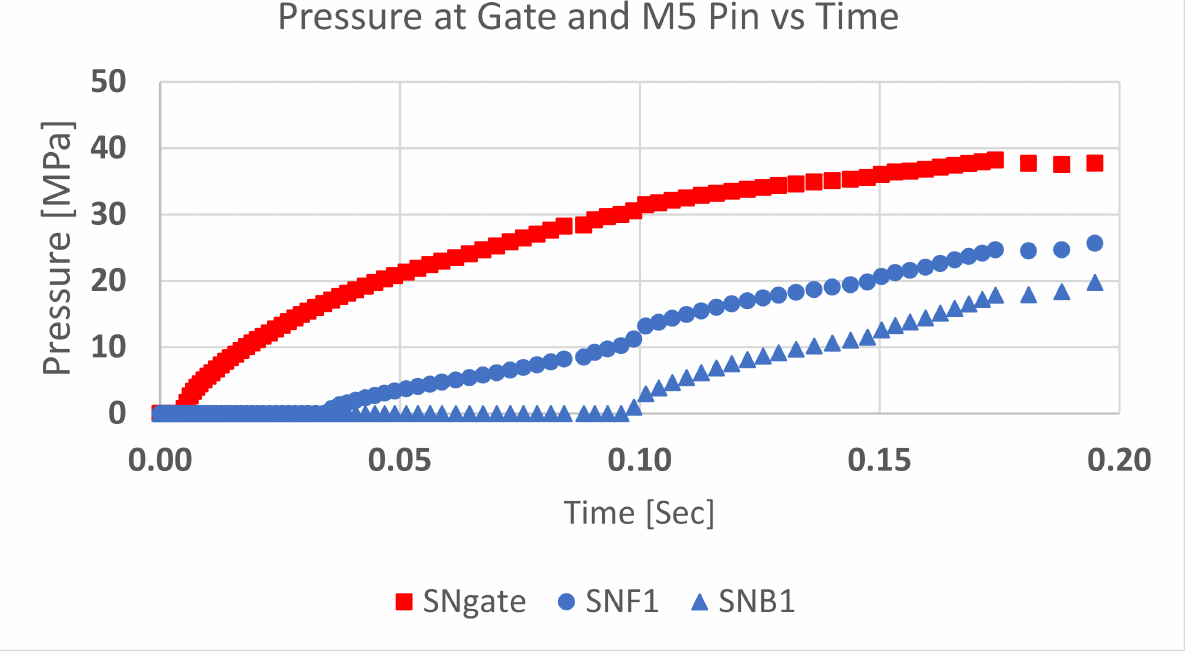
Figure 10. Pressure at the gate vs. M5 core pin. Pressure at the gate (SNgate) is higher than at the front face (SNF1). The pressure at the back face of core pin (SNB1) is less than the front face. The pressure drops along the flow length of the